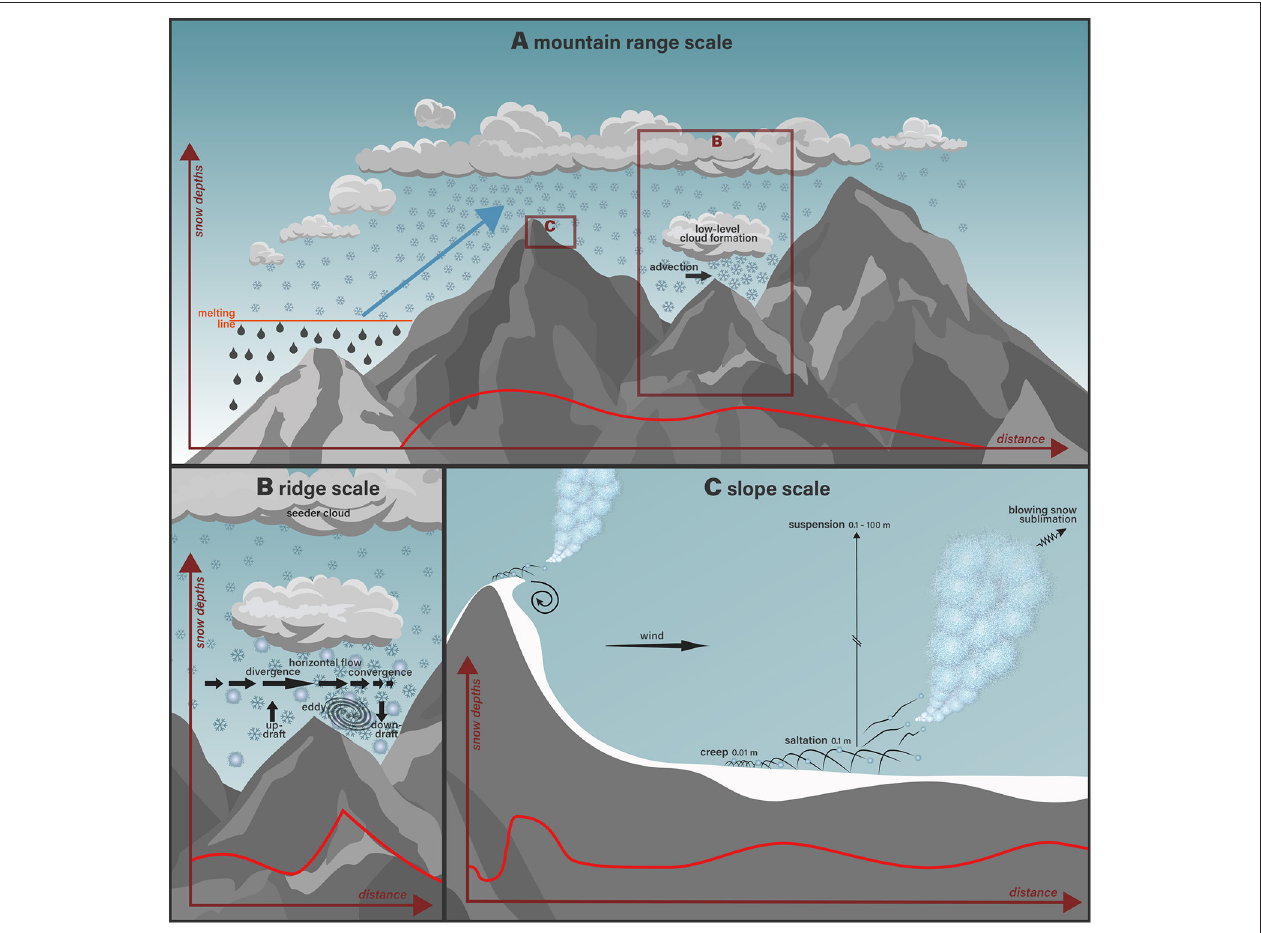
FIGURE 2 | Schematic description of snow accumulation processes acting on different scales: the Mountain range scale (A) , the ridge scale (B), and the slope scale (C) .